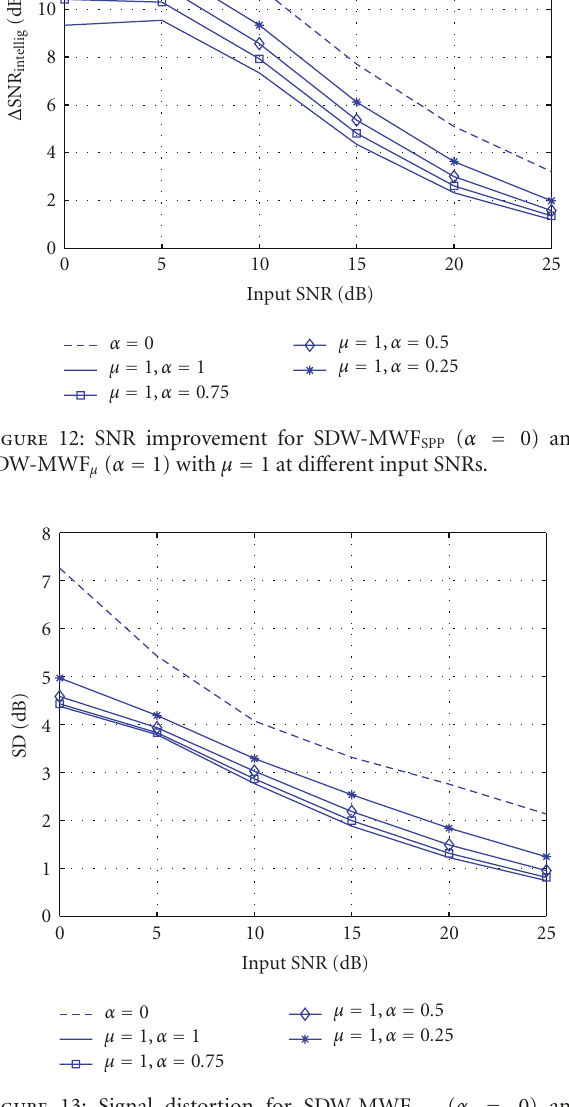
Figure 13: Signal distortion for SDW-MWF SPP ( α = 0)